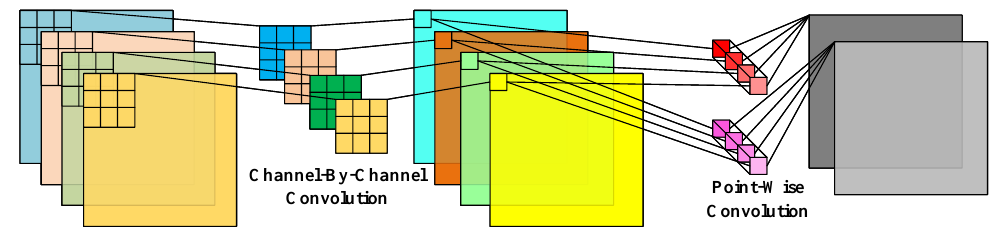
Figure 3. Schematic diagram of depth separable